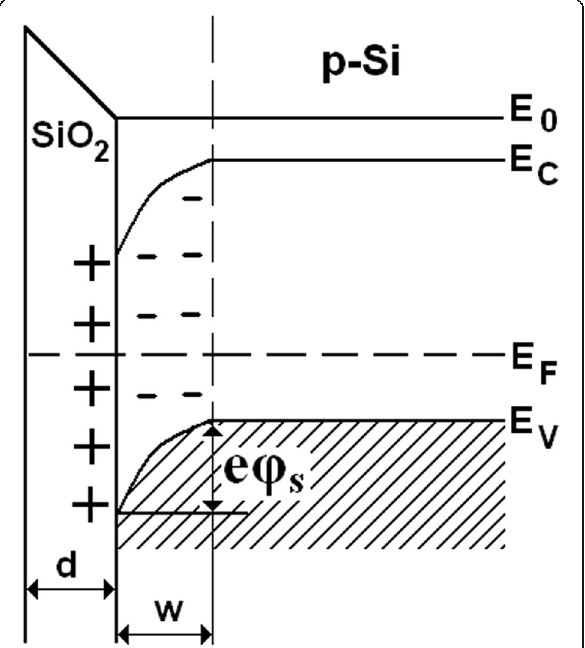
Fig. 5 Distortion of the energy bands in the p-type conductor under provided positive charge at the interface of semiconductor-insulator